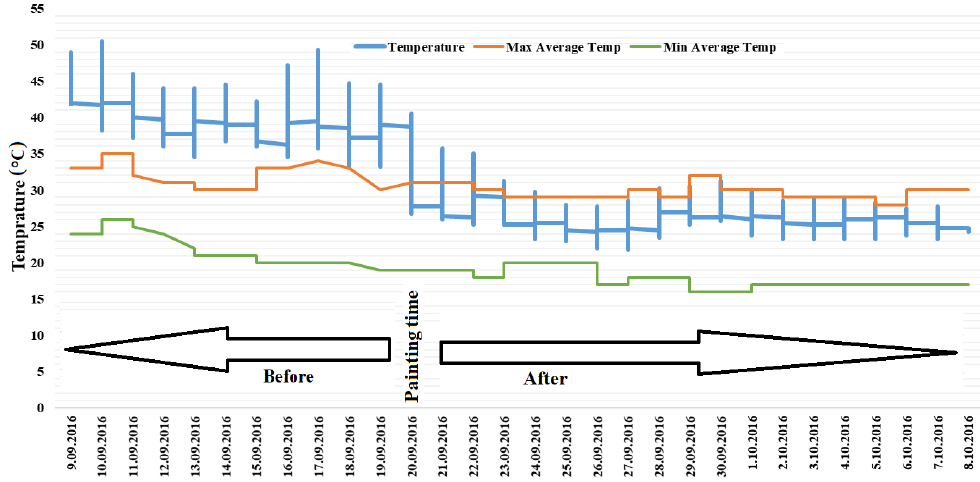
Figure 15. Measurement values of daily average and maximum/minimum temperatures for TR9.